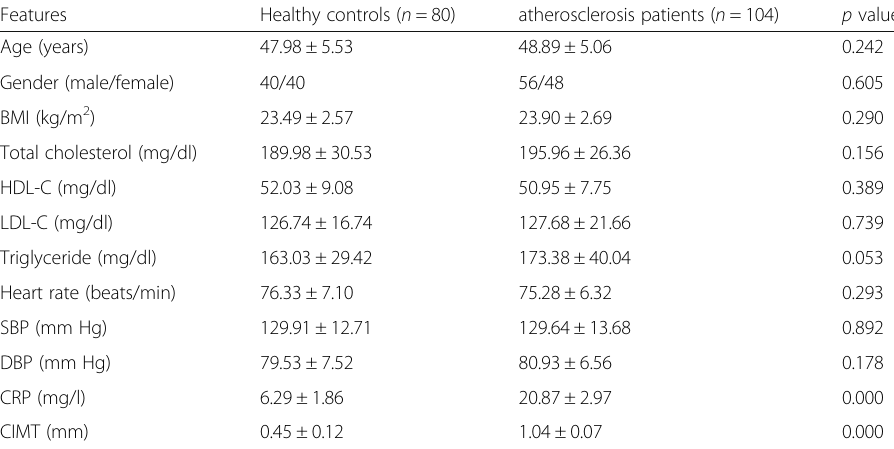
Table 1 Demographic and clinical data for the study population Features